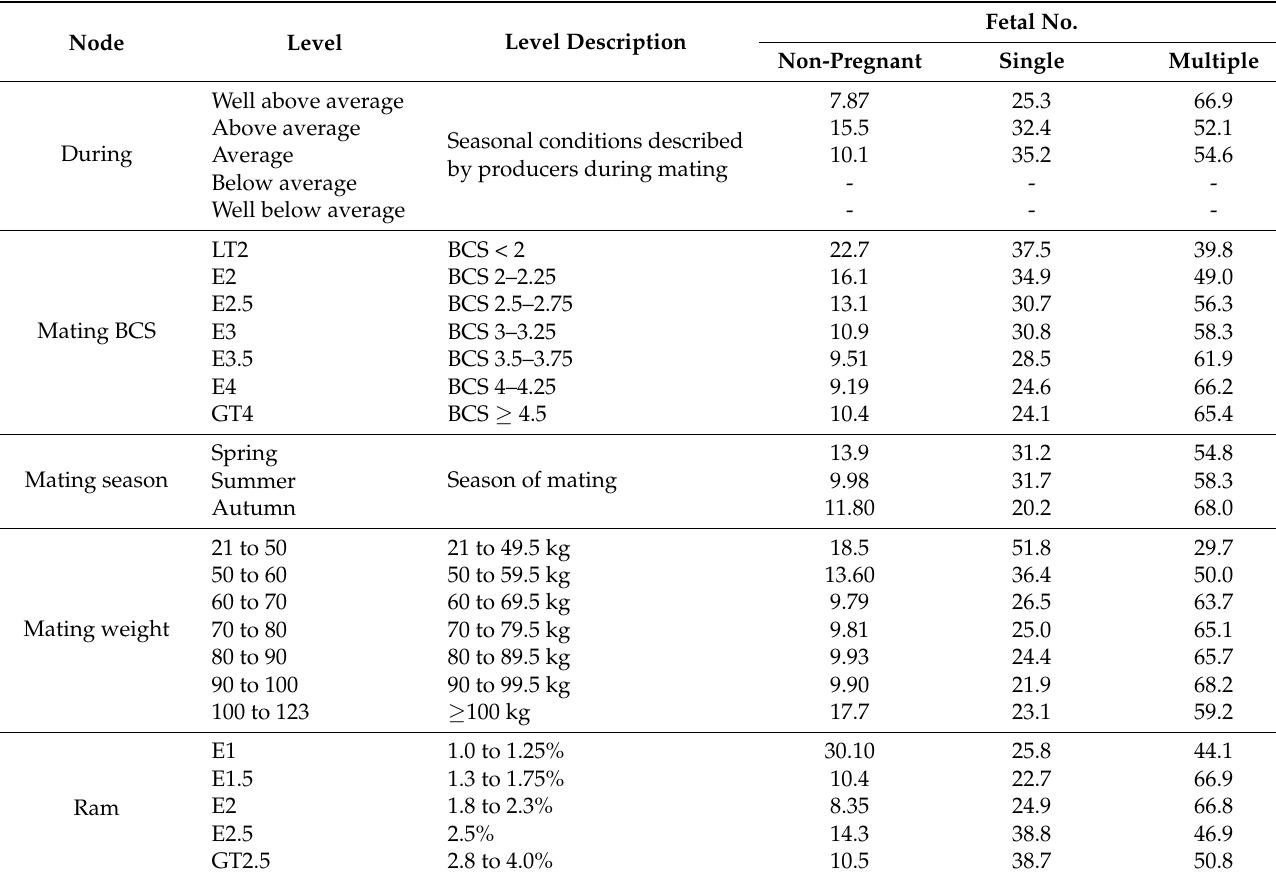
Table 5. The estimated probabilities for Maternal fetal number (no., displayed as percentages) for each node (variable) when the different levels within each node are assumed in the Bayesian Network (BN) model, where BCS = body condition score. Level descriptions detail the data and naming conventions within each level of the model. A dash (-) indicates data were not applicable for the respective level. The BN model assessed the interrelationships between pregnancy outcome and fetal number of Maternal ewes. Data displayed to three significant figures (rather than decimal places) as such the row total percentage value may be slightly different from 100% due to rounding errors. Letter prefixes are defined as: LT = less than, E = a range of values around the displayed value and GT = greater than. Region abbreviations are defined as: NSW = New South Wales, VIC = Victoria, QLD = Queensland and SA = South